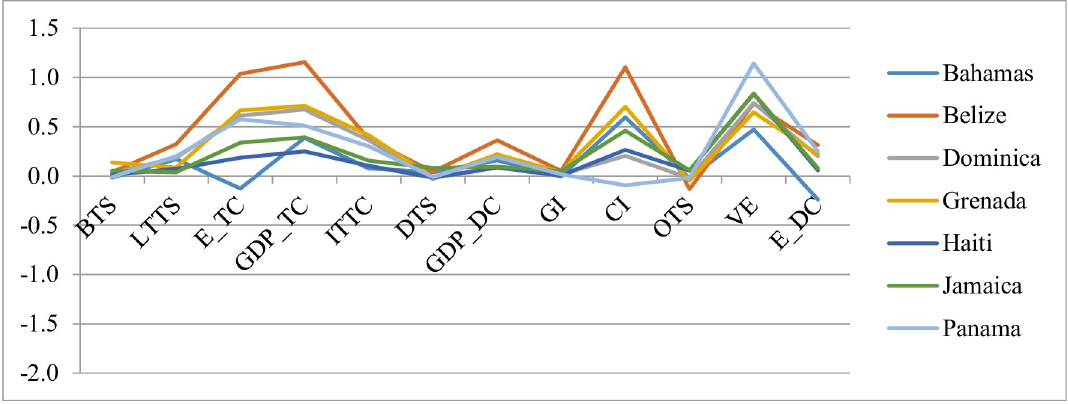
Test Statistics a.b